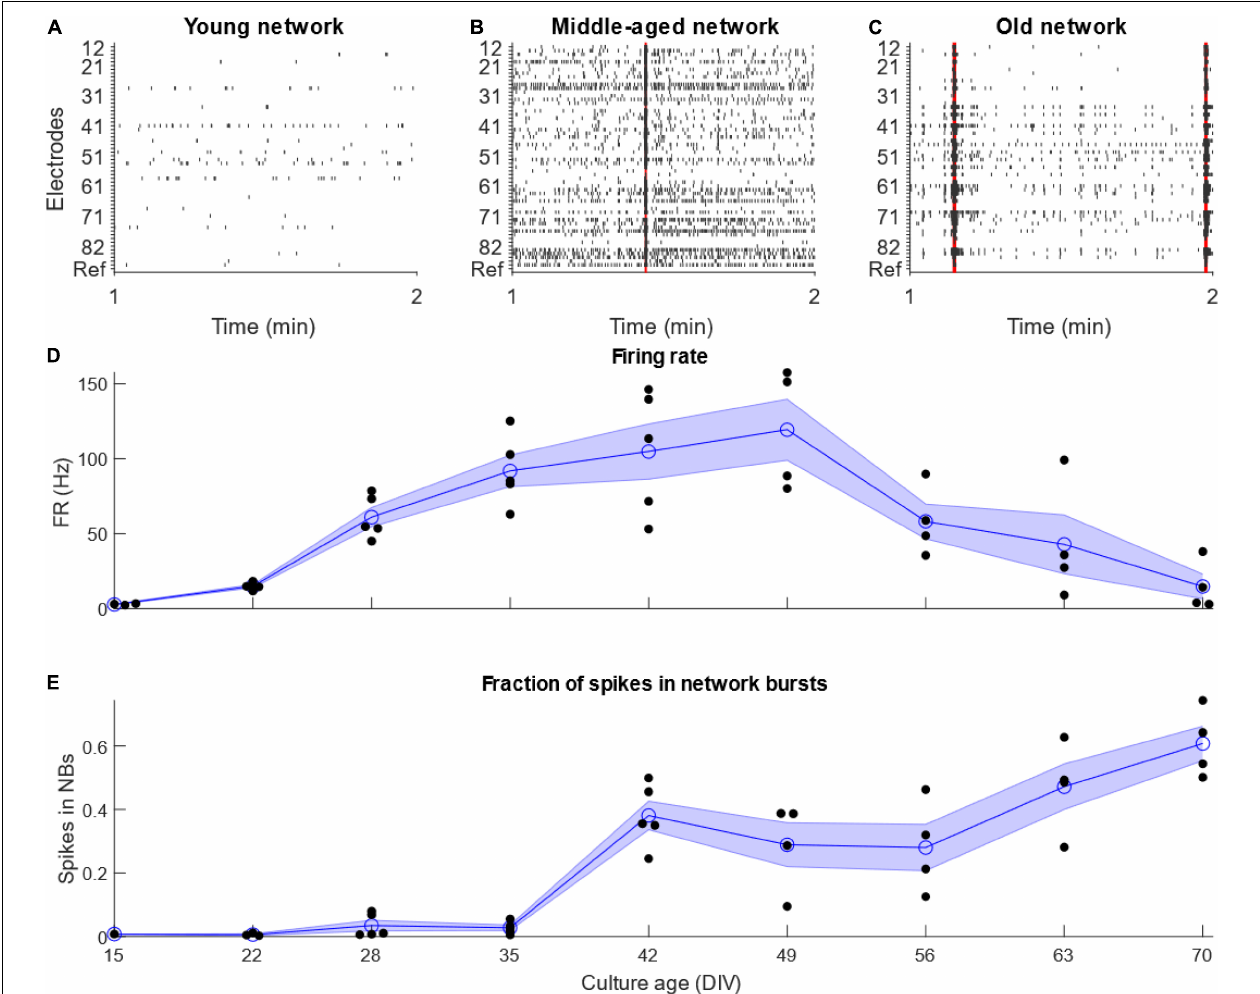
FIGURE 1 | Development of motor neuron activity. Development of activity of networks of IPSC-derived motor neurons. (A–C) Example raster plots showing 1 min of representative activity from the different stages of motor neuron network development. Red highlights show network bursts. (D) Firing rate increased until 49 DIV, after which it decreased quickly. (E) The fraction of total recorded spikes which occurred in network bursts increased for as long as the cultures were maintained. N = 5 for culture age 15–42 DIV, N = 4 from 49 to 70 DIV. Blue line and shaded region shows mean ± standard error of the mean, while black points show individual